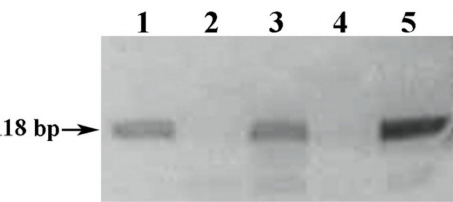
Figure 4. Electrophoregram of the result of PCR amplification of the Vitis vinifera L. UFGT gene locus with VV3-Fwd and UFGT-R primers. Legend: (1–4) PCR samples of DNA samples amplified with primers Vv3-Fwd and UFGT-R extracted from the deposited wine material debris: (1–2) a 1-h exposure of wine material mixed with isopropanol, sodium acetate and linear polyacrylamide Bioron: (1) Chardonnay; (2) Cabernet Sauvignon. (3–4) 1-h exposure of wine material mixed with isopropanol, sodium acetate and linear polyacrylamide Satellite Red: (3) Chardonnay; (4) Cabernet Sauvignon. (5) Positive control